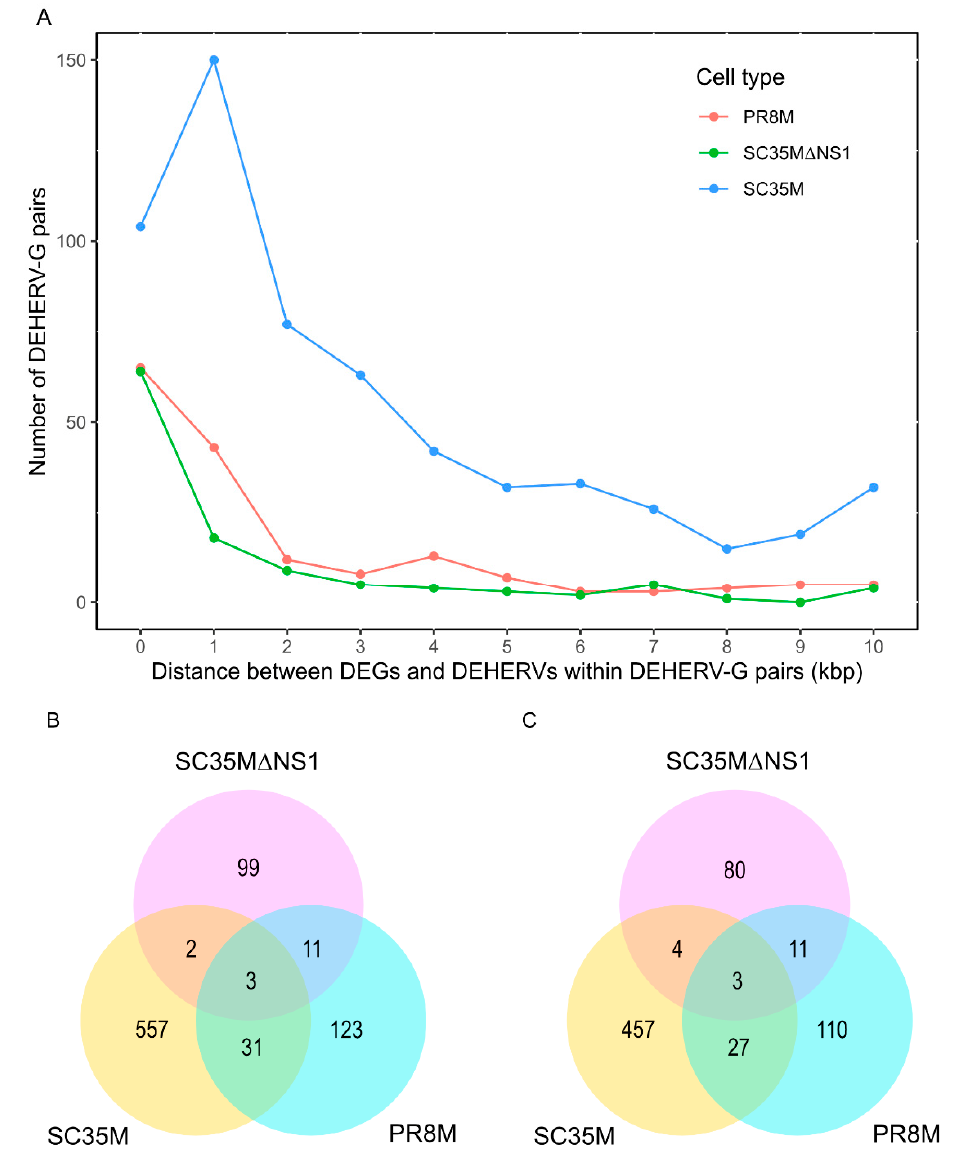
Figure 4. ( A ) Distribution of distances between DEGs and DEHERVs within DEHERV-G pairs. Zero distances correspond to overlapping DEGs and DEHERVs. ( B , C ) Overlaps between DEHERV-G pairs ( B ) and genes involved in DEHERV-G pairs ( C ) among the three IAV infected conditions vs. mock.